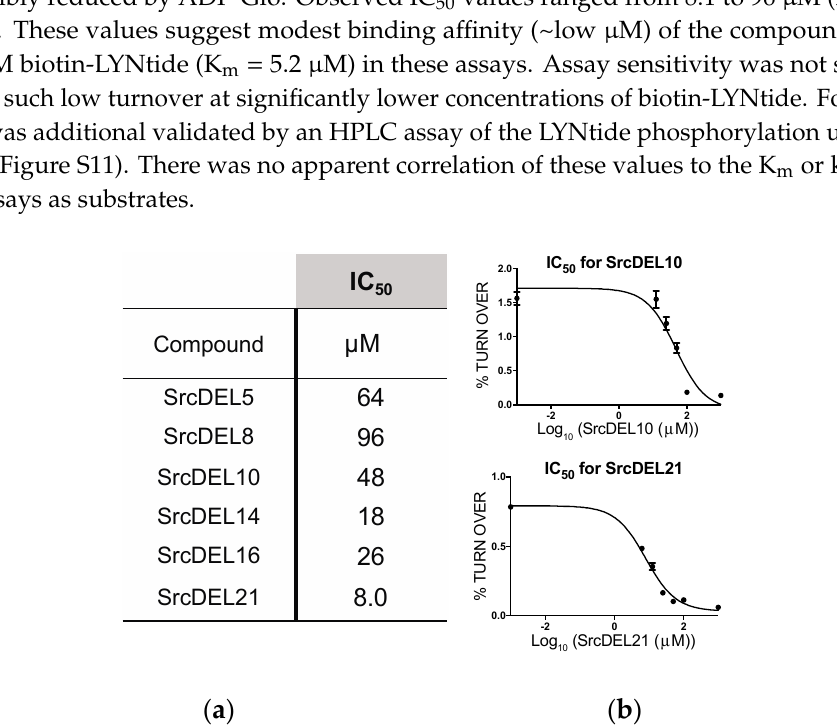
Figure 5. Structure activity relationship (SAR) studies of SrcDEL10 derivatives. ( a ) ADP-Glo assays of the SrcDEL10 derivative, SrcDEL10 – 6 , lacking a phenolic oxygen show comparable activity to